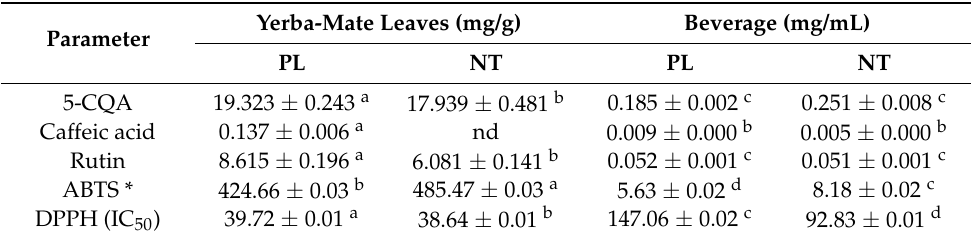
Table 2. Phenolic compounds and antioxidant activity of yerba-mate leaves and beverages. Yerba-Mate Leaves Parameter